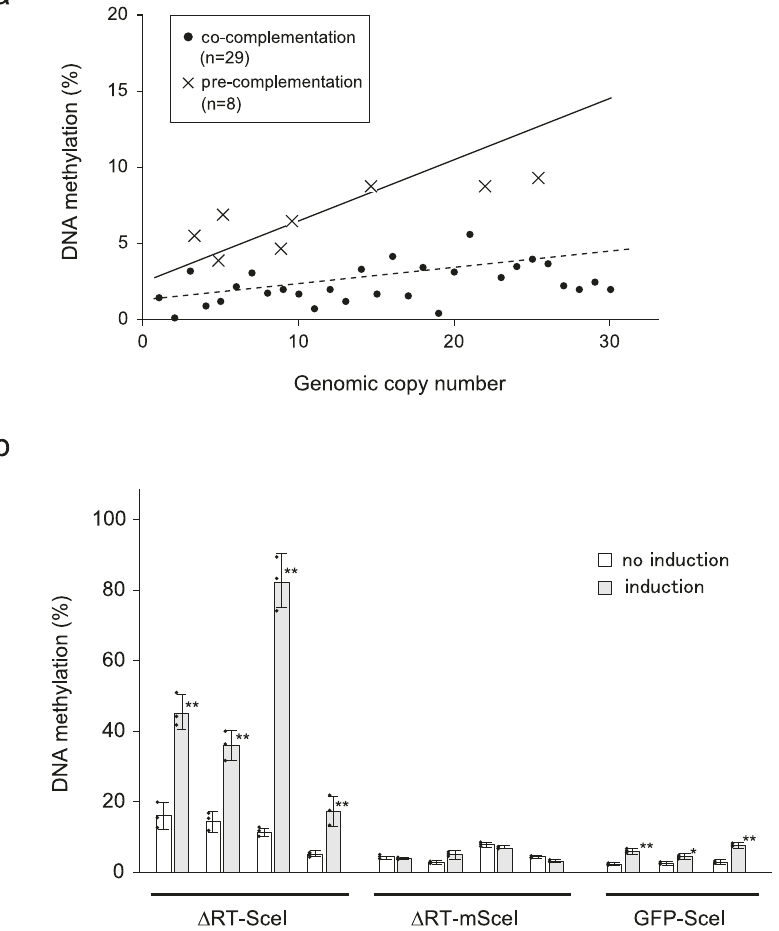
Fig. 3 de novo DNA methylation of MAGGY is associated with DNA damage. a Relation between the degree of DNA methylation and genomic copy number of MGY- Δ RT in pre-complementation and co-complementation experiments. In the pre-complementation experiment, pBS-MoRad51 carrying the wild-type Ddnm1/Rhm51 locus was fi rst introduced into the Δ ddnm1/ Δ rhm51 strain. Then, pMGY- Δ RT was further introduced into the resulting gene complemented strain. In the co-complementation experiment, pBS-MoRad51 and pMGY- Δ RT were simultaneously introduced into the Δ ddnm1/ Δ rhm51 strain. The solid and dashed lines in the graph represent the regression lines of the wild-type and Δ ddnm1/ Δ rhm51( Δ 11350) strains shown in Fig. 1a, respectively. b The restriction sequence of I-SceI (SceI) or its mutated sequence (mSceI) was introduced in the reverse-transcriptase domain of pMGY- Δ RT or the EGFP coding sequence of pEGFP75. Each of the resulting constructs was introduced into a P. oryzae strain possessing pEG2-SceI, a plasmid expressing I-SceI under the control of the cellulose-inducible MoCel7C promoter. The transformants were cultured in CM media containing 1% glucose for 3 days, and transferred to CM media containing 1% cellulose (induction) or 1% glucose (no induction). After culturing for 24 h under inductive or non-inductive conditions, mycelia were harvested and subjected to qMSER analysis. Each bar represents the average of three replicates (±SE). Asterisks denote statistically signi fi cant difference from no induction by Student ’ s t test (* P < 0.05; ** P <